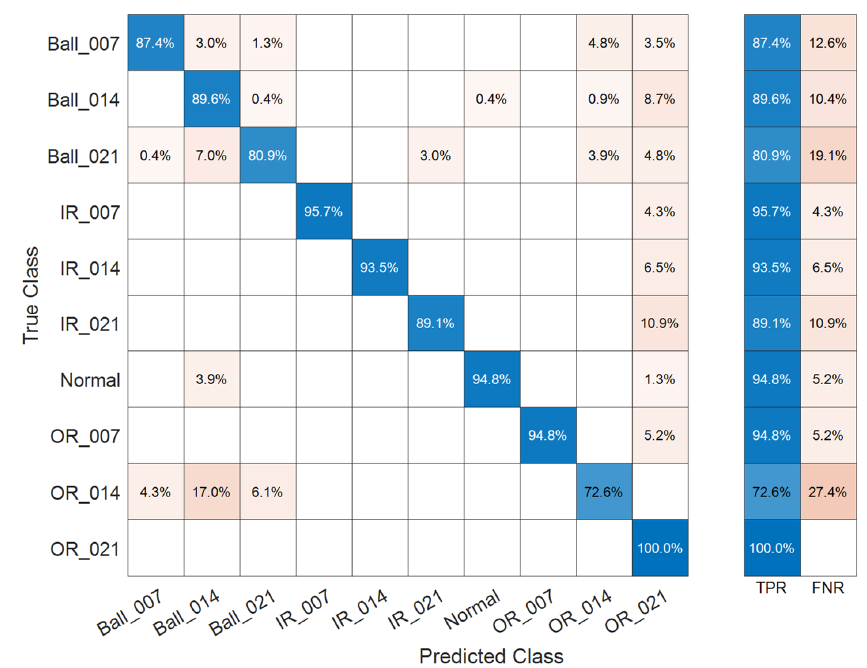
Figure 7. Confusion matrix of motor bearing failure prediction in fine Gaussian SVM, with a total accuracy of 89.6%.